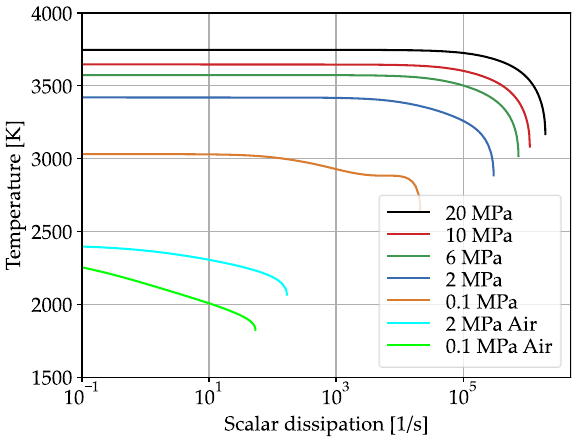
Figure 3. Temperature dependent on scalar dissipation at the respective stoichiometric point for methane–oxygen and methane–air flames at different pressures.